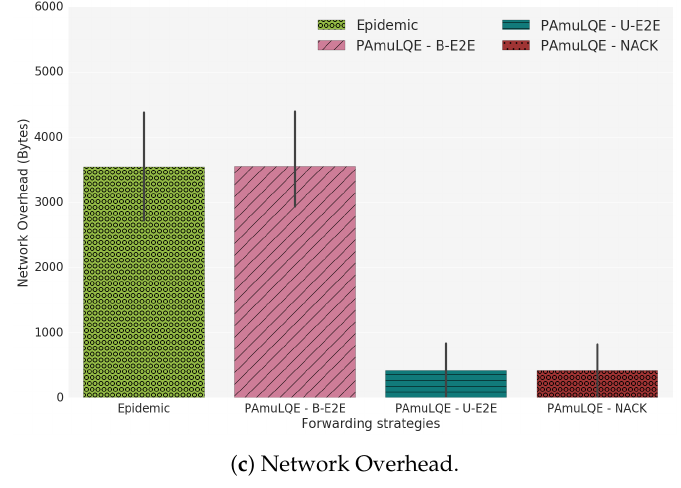
( c ) Network Overhead. Figure 26. Test E1, Scenario